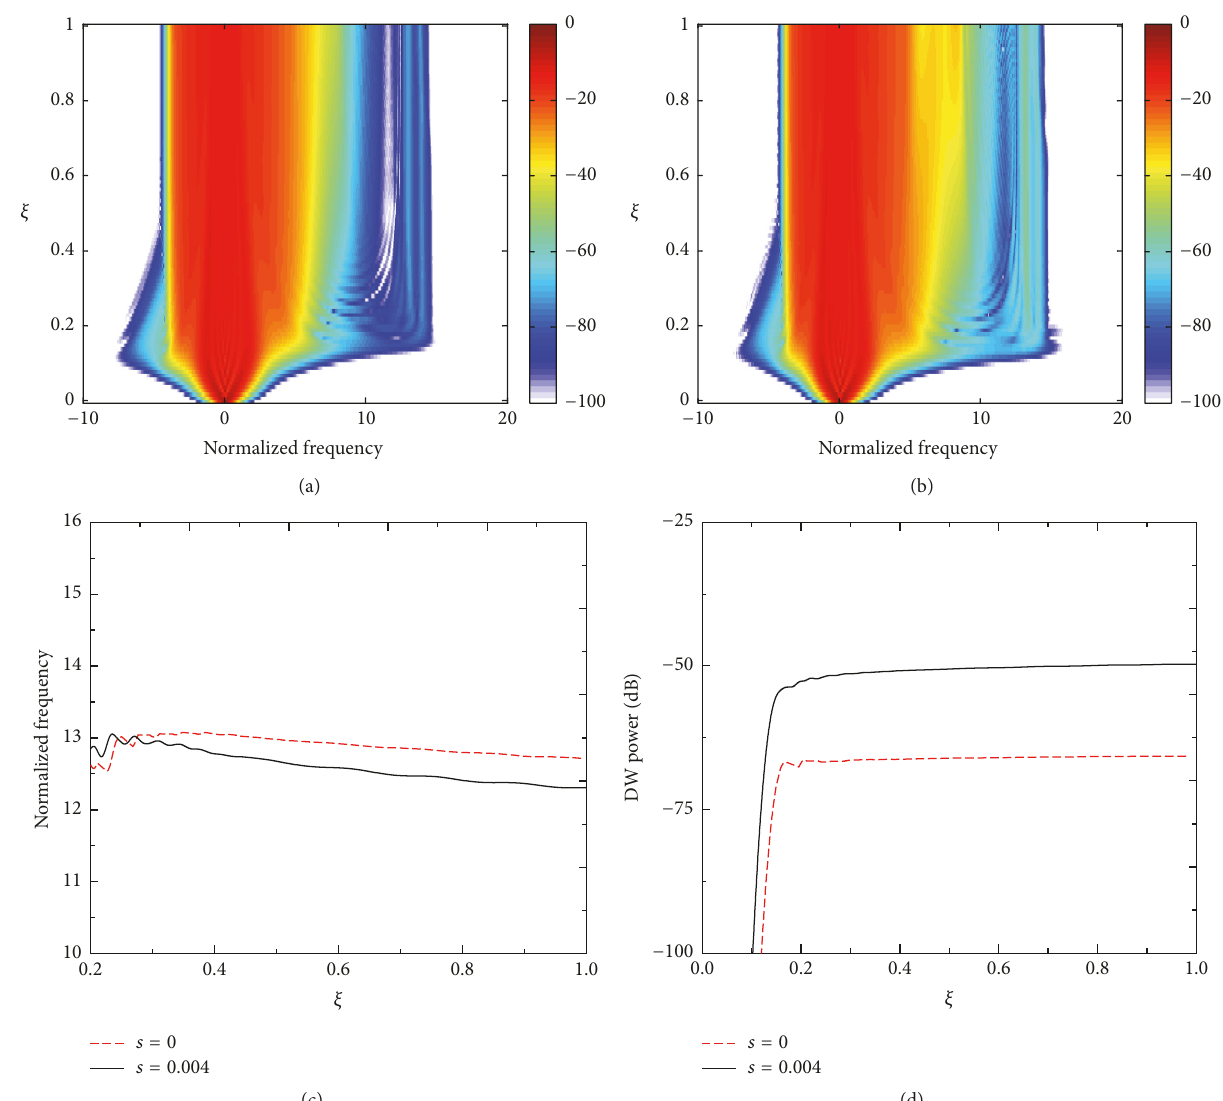
Figure 3: Simulate spectrum of a hyperbolic secant pulse propagating in the normal dispersion regime at the different SS coefficients, (a) 𝑠 = 0 and (b) 𝑠 = 0.004 , where 𝛿 = −0.0267 and 𝑁 2 = 200 . Central frequency (c) and the relative average intensity (d) of the blue-shift DW 3 as a function of normalized propagation distance, where 𝑠 = 0 (red dashed curve) and 𝑠 = 0.004 (dark solid curve).